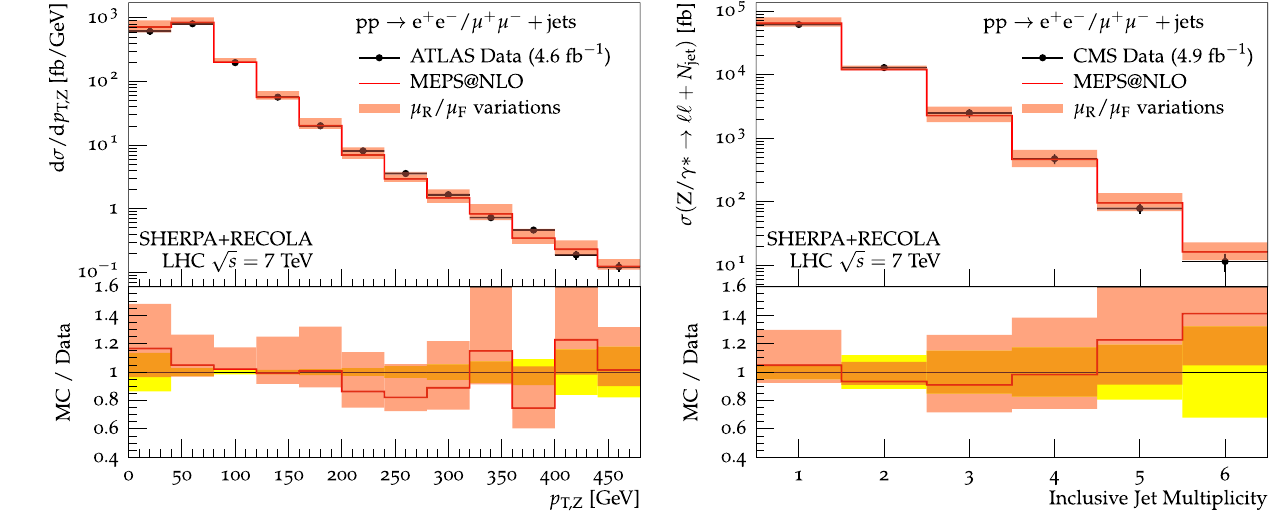
Fig. 5 The left-hand figure compares the MEPS@NLO predictions based on Sherpa + Recola for the transverse-momentum distribution of the reconstructed Z boson compared to ATLAS [73]. The right-hand figure shows the inclusive jet multiplic-